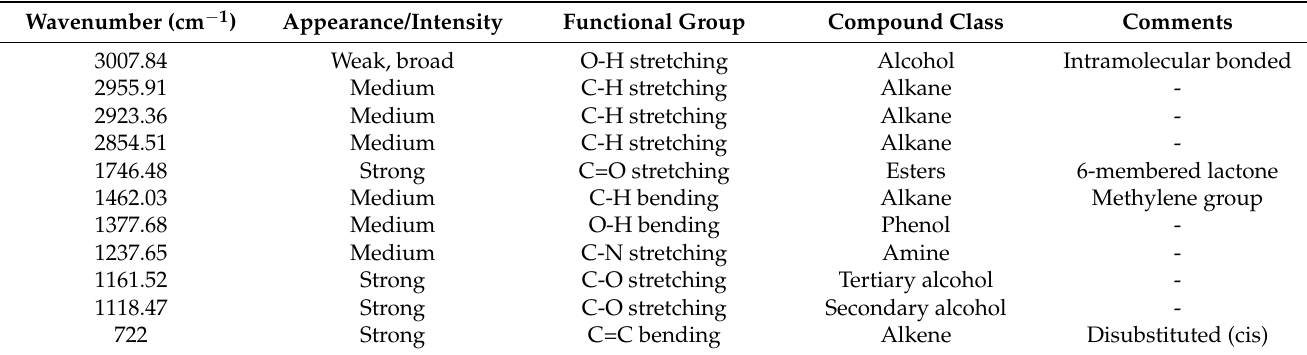
Table 2. Functional group of Malaysian Jatropha seed